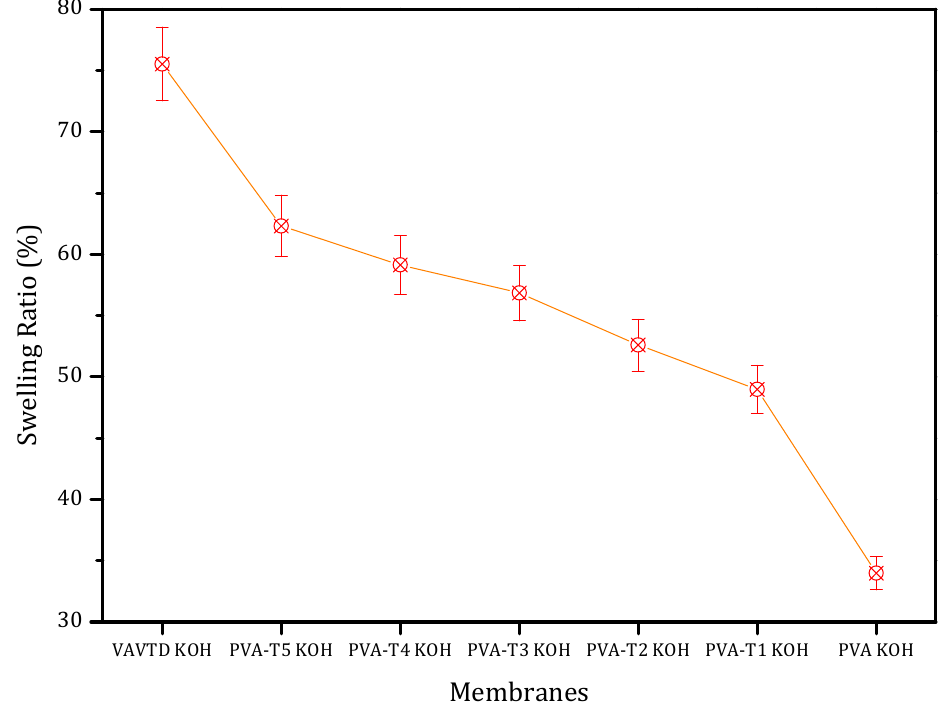
Figure 1. Swelling ratio of the PVA-VAVTD KOH matrix as a function of the VAVTD increase in membrane.